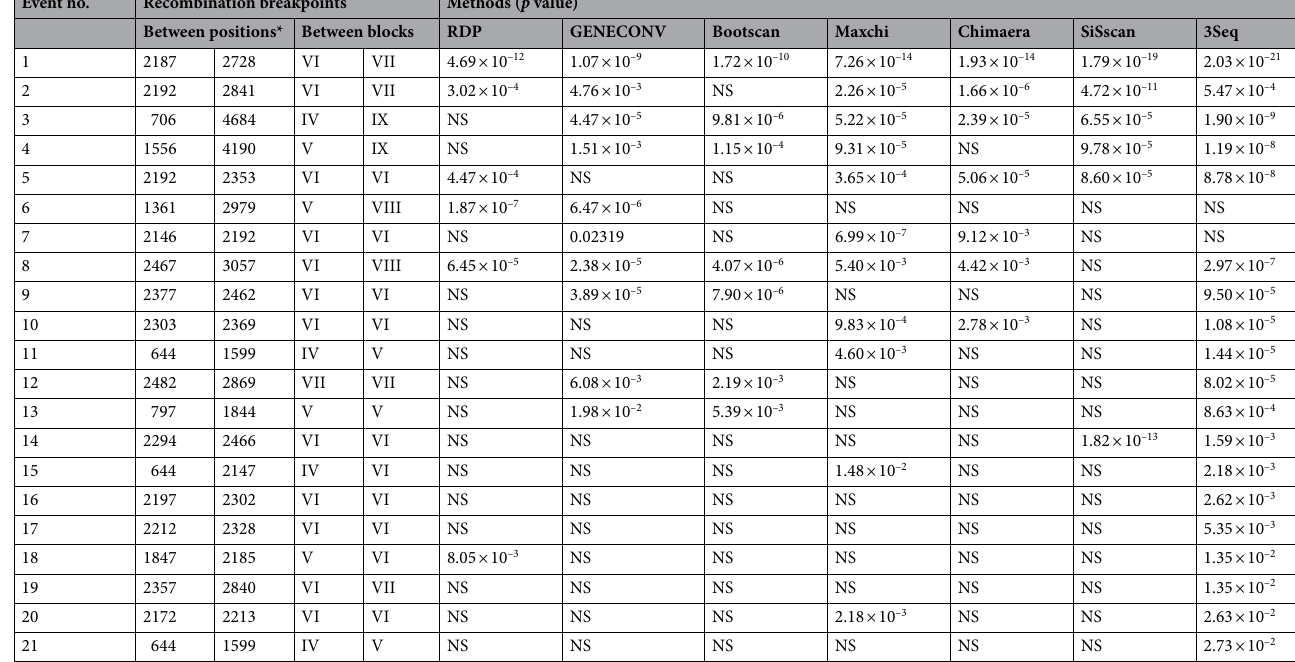
Table 5. Intragenic recombination in PmMSP1 inferred from 35 Thai isolates. *Positions after the FJ824669